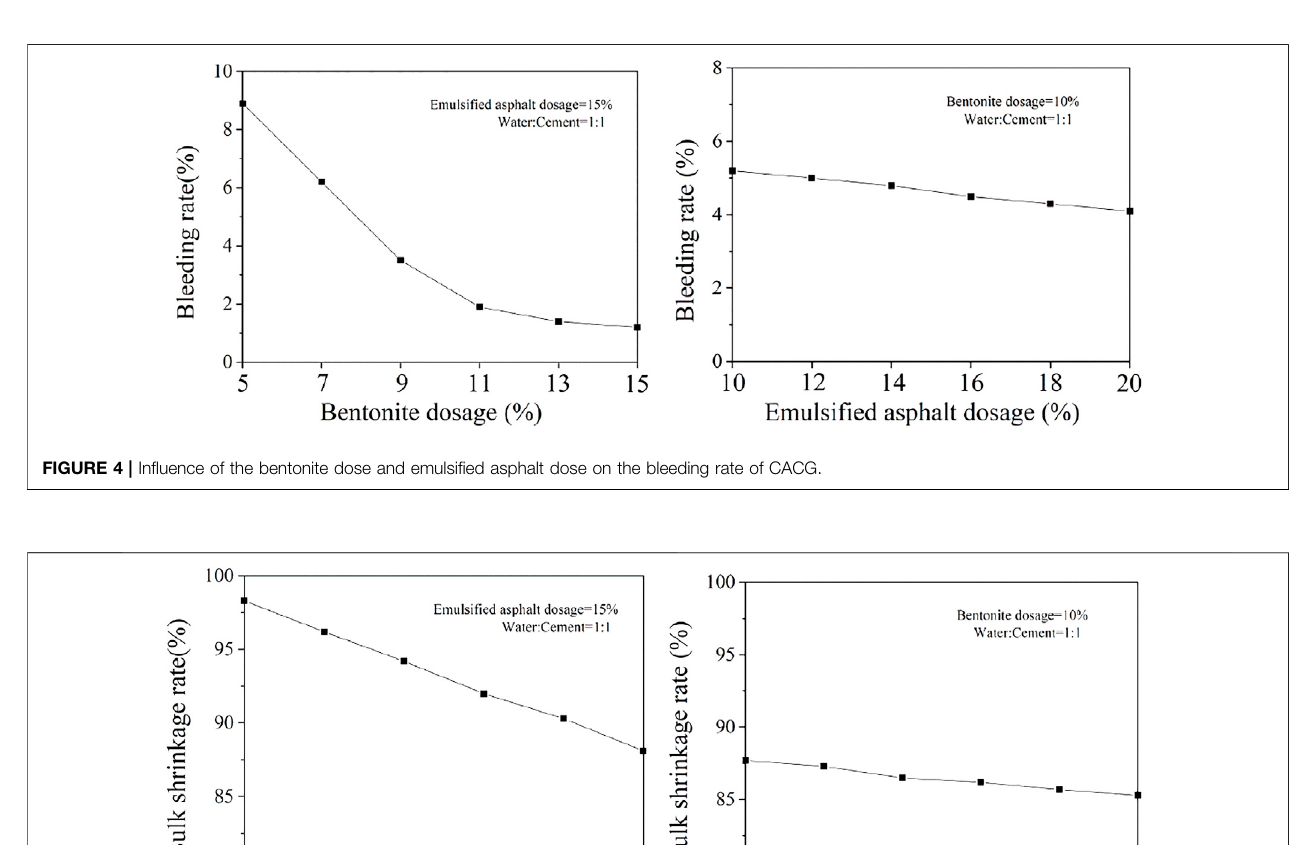
FIGURE 3 | In fl uence of bentonite dose and emulsi fi ed asphalt dose on the fl uidity of CACG.